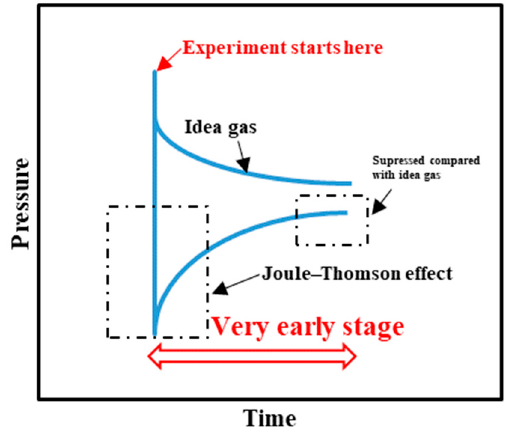
Figure 9. Conceptual pressure plot in the upstream illustrating the influence of Joule – Thomson effect on the pressure